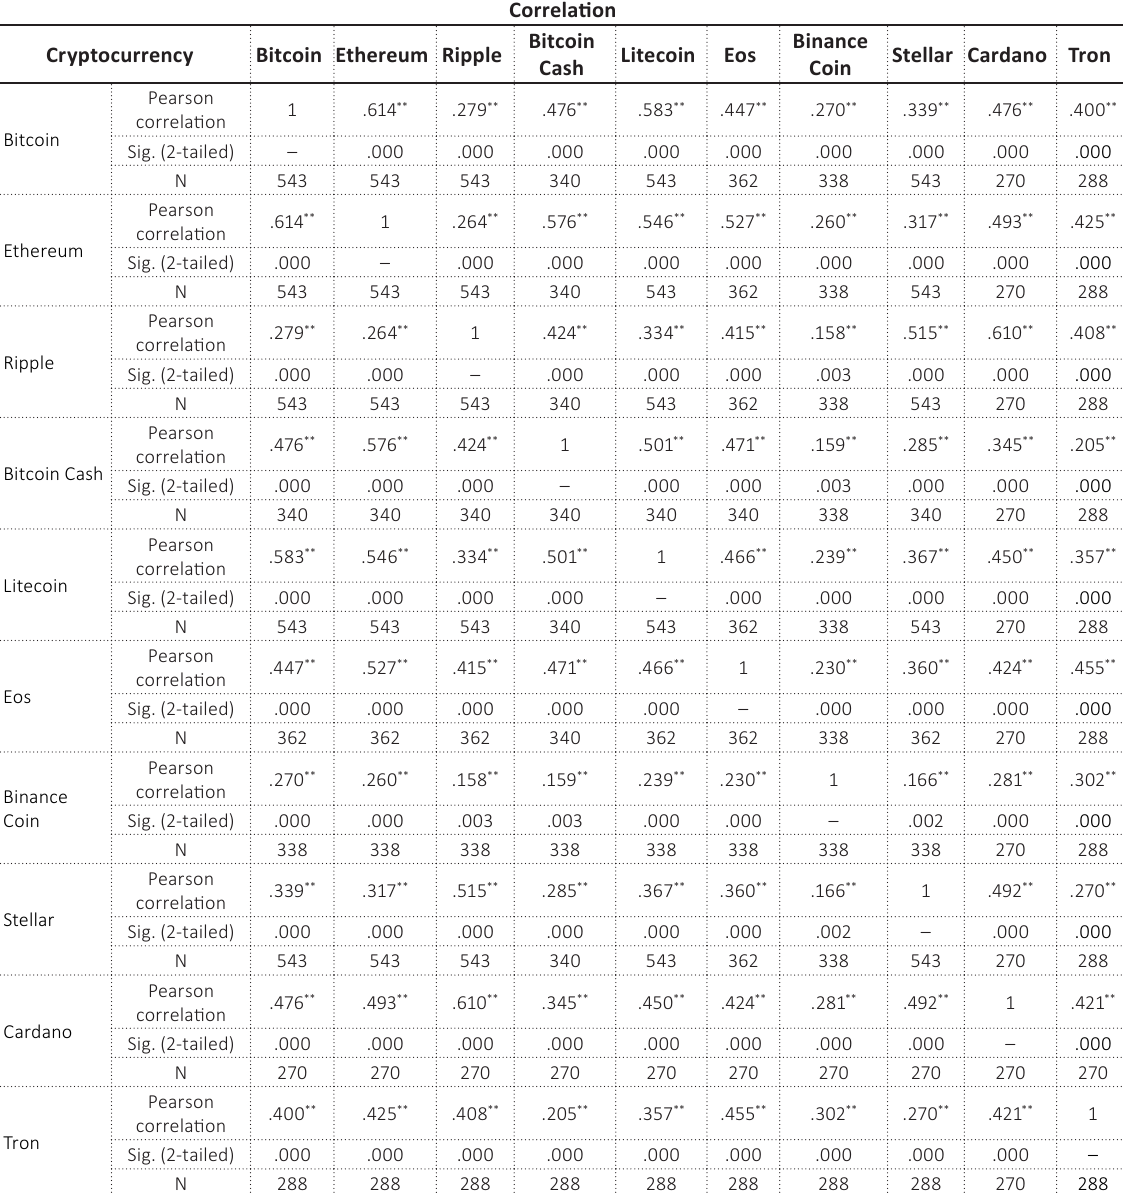
Table 2. Pearson correlation coefficients between cryptocurrency pairs for the period of increasing prices (daily